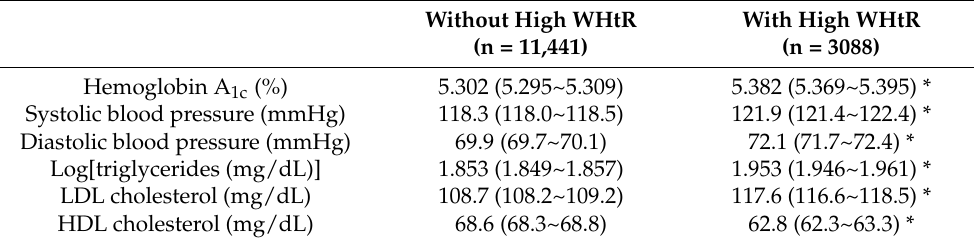
Table 4. Comparisons of cardiometabolic risk factors between subjects without and with a high waist-to-height ratio in the subject group not showing large waist circumference and high BMI in multivariable